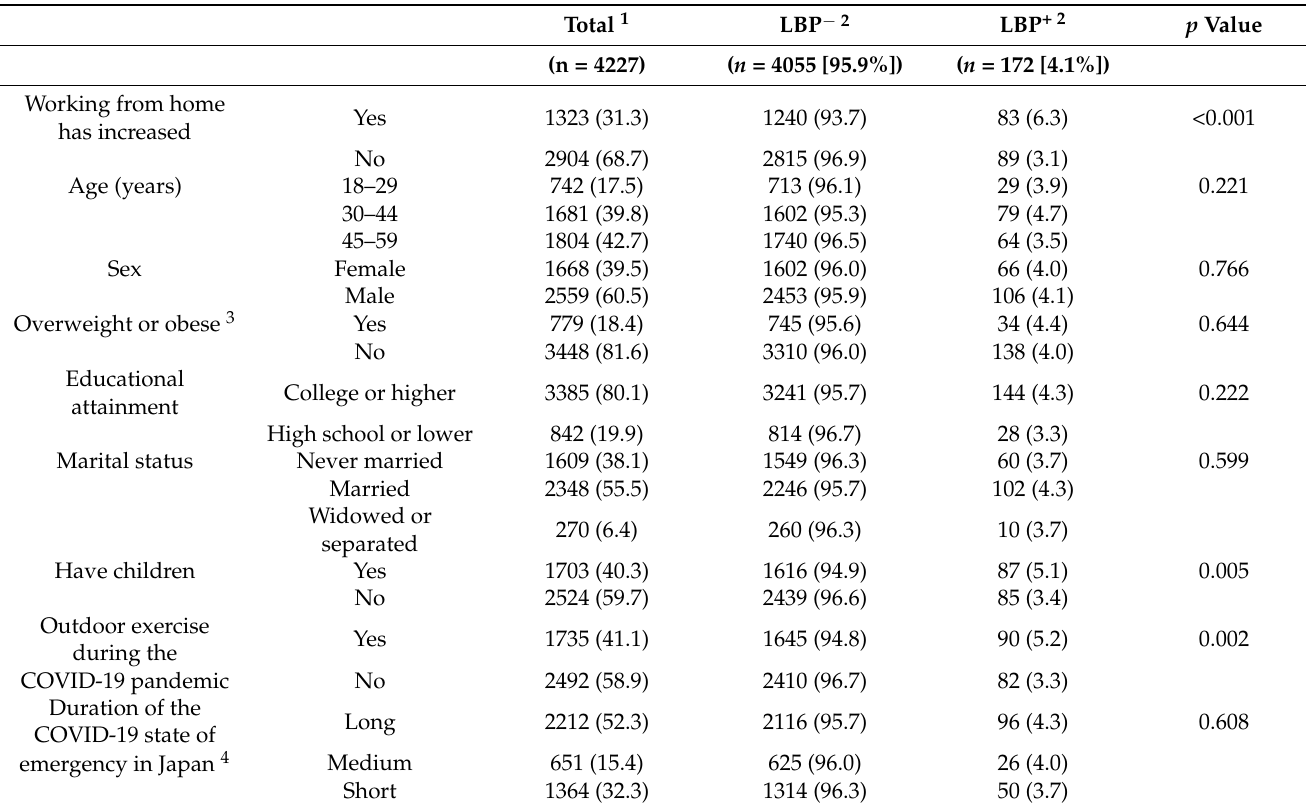
Figure 1. Flow diagram of the study participants. Table 1. Characteristics of study participants (desk workers aged 18–59 years).